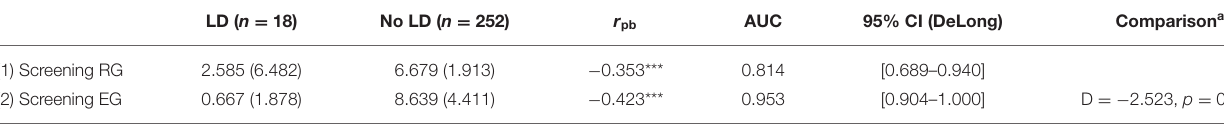
TABLE 3 | Descriptive statistics and AUC for the subtests.